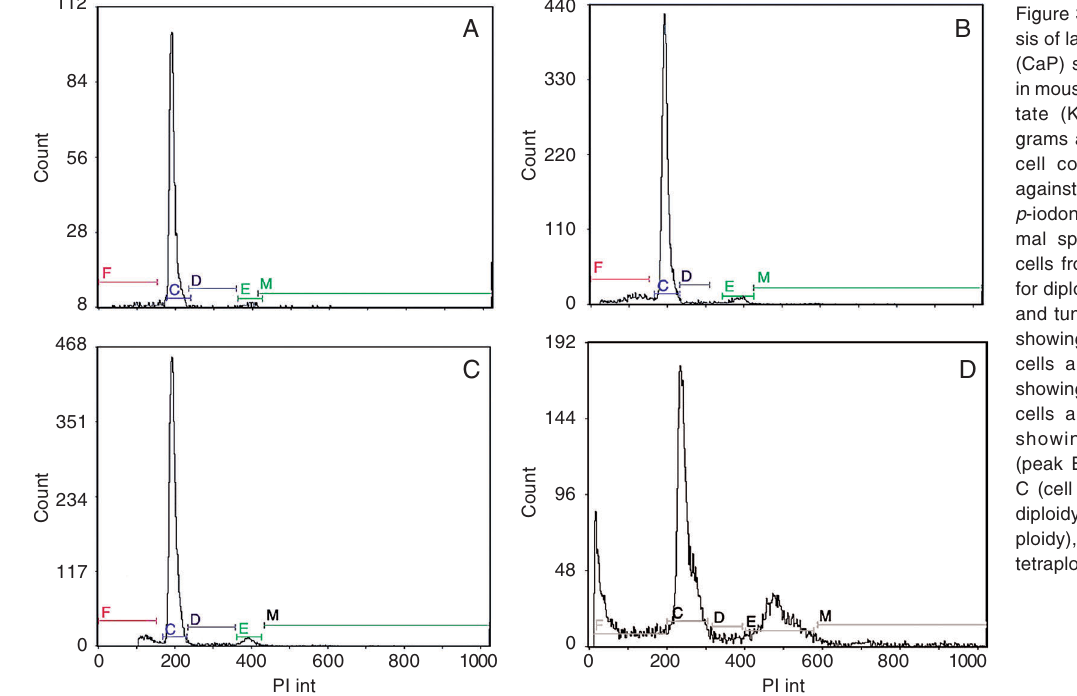
Figure 3. Flow cytometry analy- sis of late stage prostate cancer (CaP) samples from the knock- in mouse adenocarcinoma pros- tate (KIMAP) model. All dia- grams are singlet pictures, with cell counts (ordinate) plotted against PI int (propidium iodide p -iodonitrotetrazolium). A , Nor- mal spleen tissue dissociated cells from KIMAP mice (control for diploid); B , mixture of spleen and tumor cells of KIMAP mice showing diploidy; C , test of CaP cells alone from KIMAP mice showing diploidy; D , test of CaP cells alone from KIMAP mice showing tetraploid changes (peak E). Peaks correspond to C (cell cycle phase G0/G1, for diploidy), D (S phase for aneu- ploidy), and E (G 2 M phase for